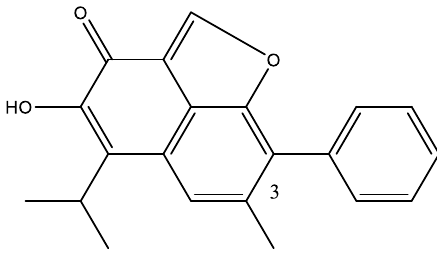
Figure 10. Dehydrogossypol. Figure 10.